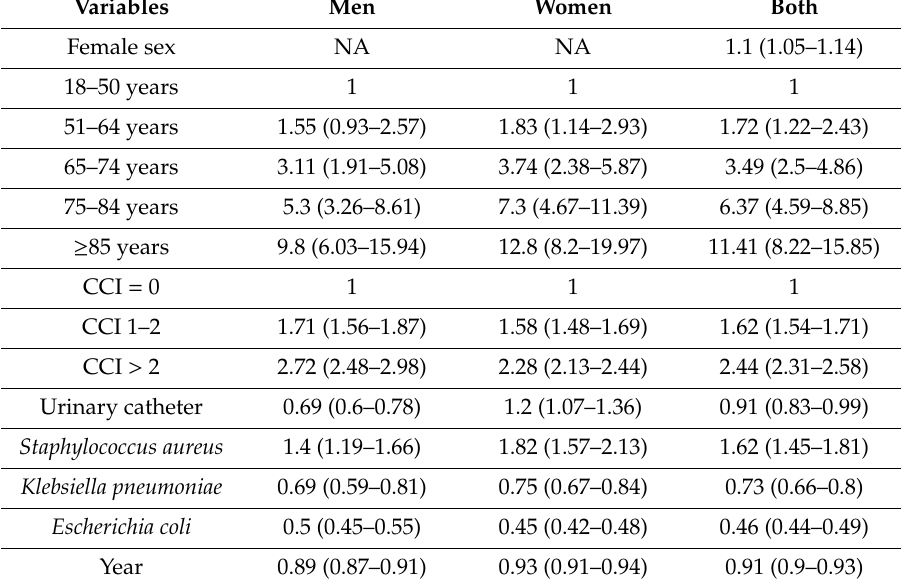
Table 4. Variables associated with in-hospital mortality in hospital admissions of T2DM patients with a principal diagnosis of urinary tract infection according to sex in Spain